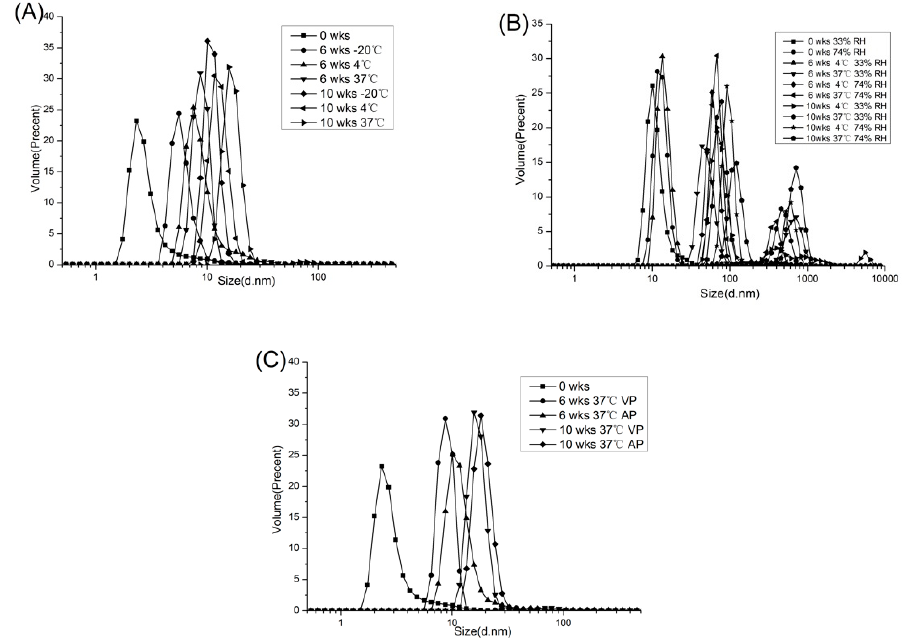
Figure 3. Changes in particle size volume distribution of PPI stored at different temperature ( A ), relative humidity ( B ) and packaging methods ( C ).